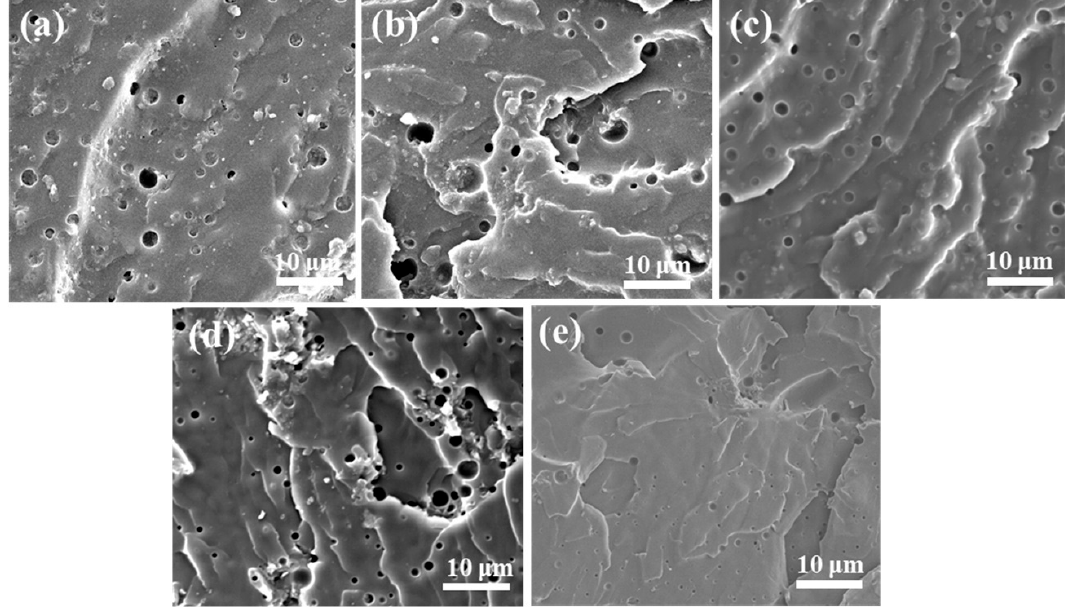
Figure 6. Fracture surface morphology of ( a ) pure epoxy, ( b ) EP-GO, ( c ) EP-G-K, ( d ) EP-G-S, ( e ) EP-G-S-K-coated Q235 carbon